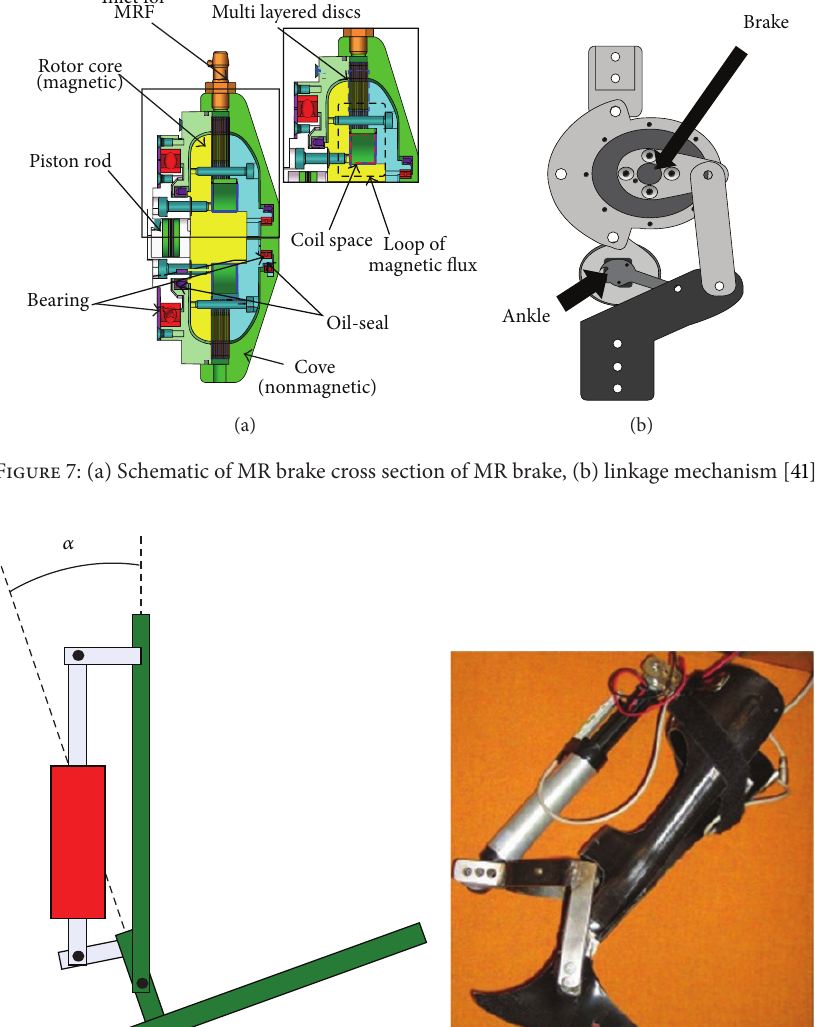
magnetorheological fluid brake (CMRFB). This new AFO is less in weight (990 g) compared to the previous prototype